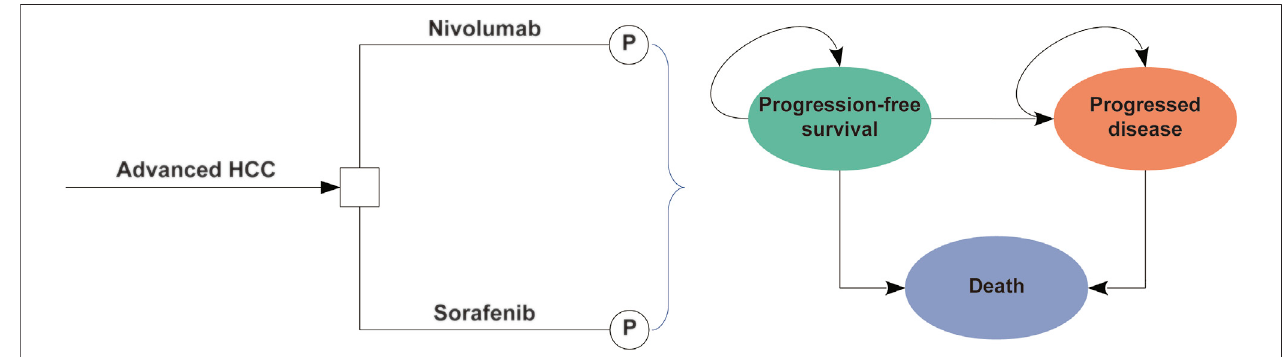
FIGURE 1 | The partitioned survival model consisting of three discrete health states. Abbreviations: HCC, hepatocellular carcinoma; P, partitioned survival model.